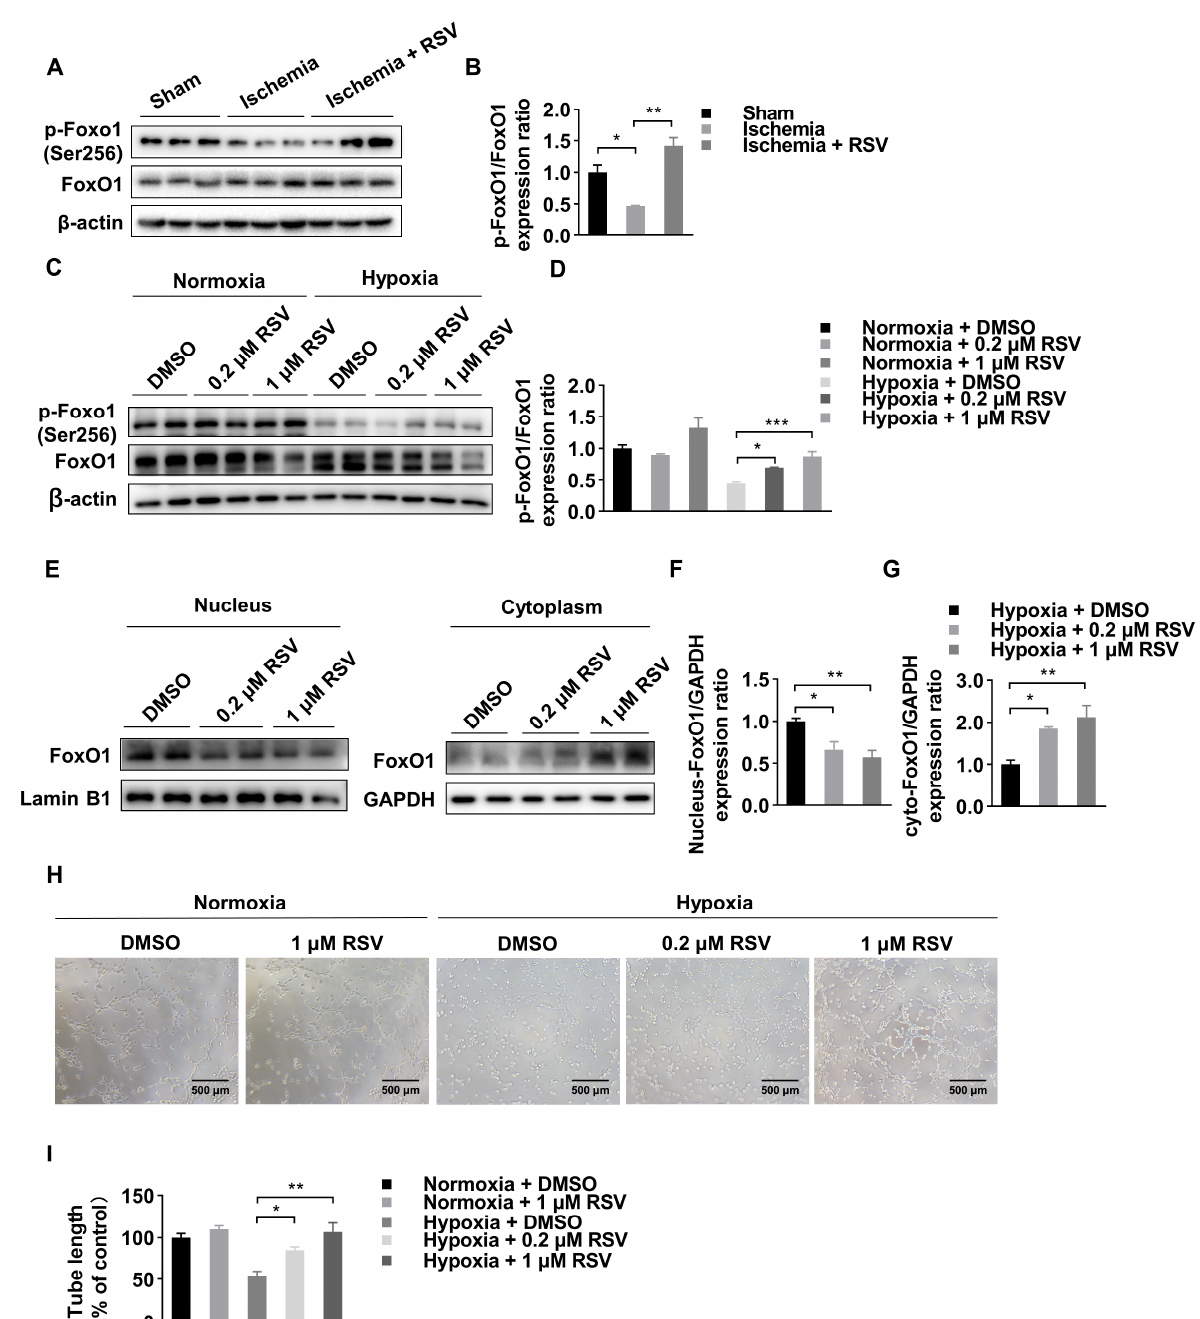
Figure 2. Identification of FoxO1 change in vitro and in vivo. ( A ) Ischemic skeletal muscles lysates were used to detect the FoxO1 and the phosphorylation of FoxO1 by Western blot. ( B ) Quantitative analysis of Western blot. Data were shown as mean ± SEM ( n = 3, * p < 0.05; ** p < 0.01). ( C ) Total expression of FoxO1 and phosphorylation of FoxO1 under normoxia and hypoxia conditions in vitro. HUVECs were treated with DMSO or RSV for 0.2 and 1 μ M for 6 h. ( D ) Quantitative analysis of Western blot. Data were shown as mean ± SEM (* p < 0.05; *** p < 0.001). ( E ) RSV treatment led to nuclear-cytoplasmic shuttling in HUVECs as determined by Western blot of nuclear and cytoplasmic lysates, cells were treated with DMSO or RSV for 0.2 and 1 μ M for 6 h under hypoxia condition. ( F , G ) Quantitative analysis of Western blot. Data were shown as mean ± SEM (* p < 0.05; ** p < 0.01). ( H ) Hypoxic pretreatment and normal HUVECs were seeded in 96-well plates precoating Matrigel, and incubated with RSV of 0.2 and 1 μ M for 8 h under hypoxia condition. Capillary like tube formation was captured by a digital camera attached to a microscope (100×, scale bar = 500 μ m). ( I ) Quantitative analysis of tube formation assay. Data were shown as mean ± SEM (* p < 0.05; ** p < 0.01).